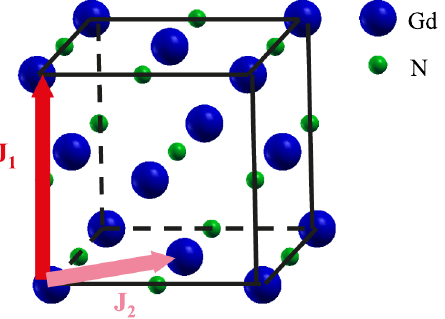
FIG. 1. The unit cell of a GdN bulk. The Gd-to-Gd arrows indicate the NN (diagonal, pink) and next-NN (linear, red)